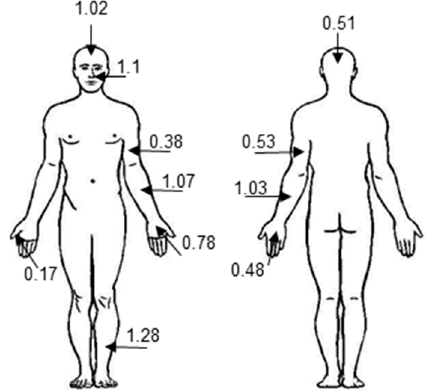
Figure 1. RNase 7 concentration is site-dependent. Defined skin areas of probands ( n = 10) were rinsed with 10 mM of sodium phosphate buffer containing 150 mM of NaCl, pH 7.4. The RNase 7 protein concentration was determined by ELISA. The depicted RNase 7 concentrations refer to ng/cm 2 [13]. Data are mean values ( n = 10).